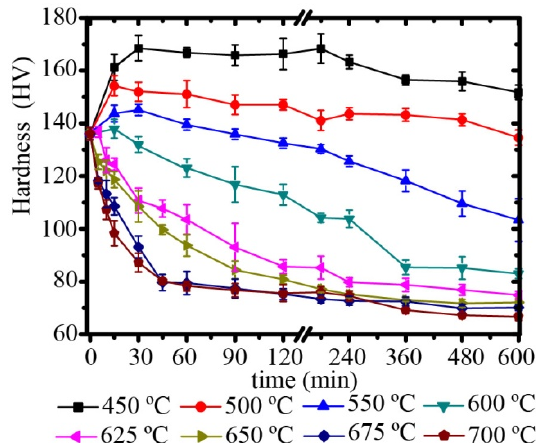
Figure 1. Vickers hardness of 60% cold-drawn Cu–Cr–In alloy annealed at di ff erent temperatures and for di ff erent times.